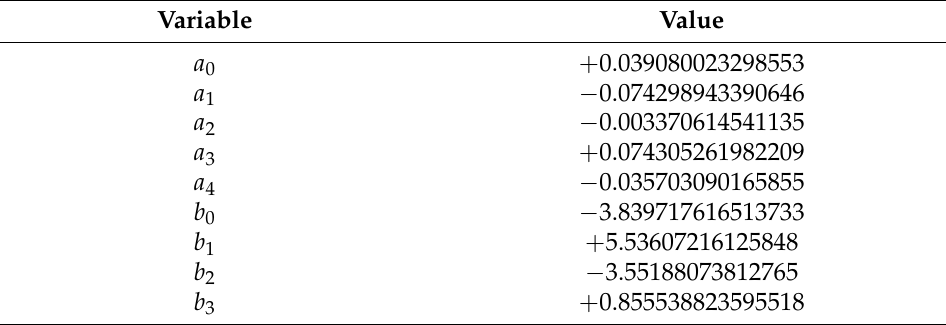
Table A3. Difference in equation constants for the z Cartesian